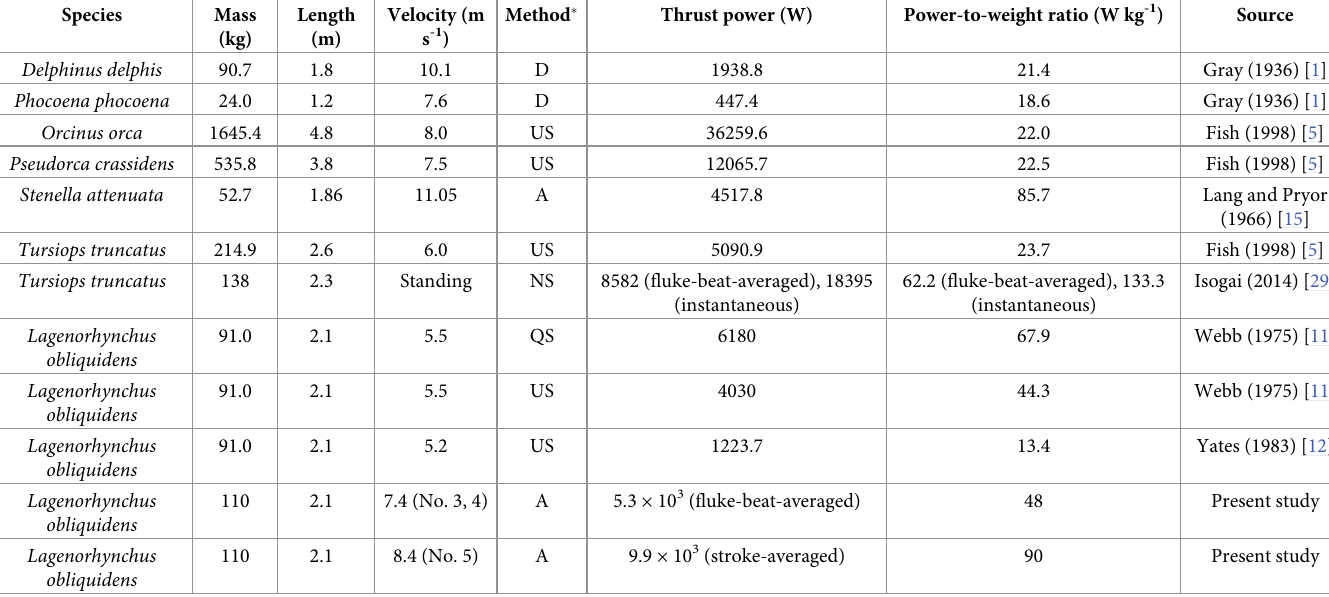
Table 3. Thrust power of dolphins in high-speed swimming and standing swimming.